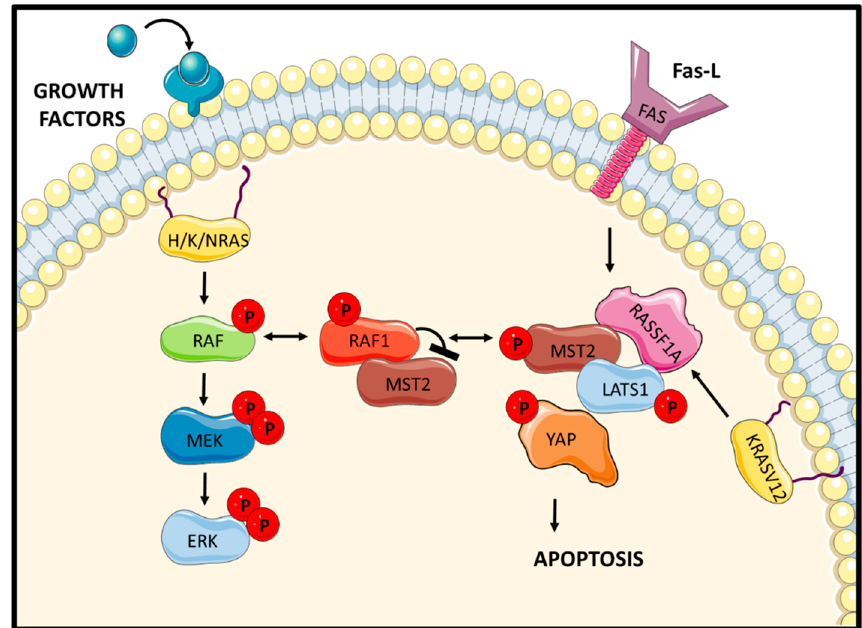
Figure 4. RAF1 negatively regulates the proapoptotic Hippo pathway by binding to MST2 upon growth factor stimulation. RASSF1A rescues MST2 from the inhibitory binding of RAF1 and regulates the activation of the core proteins of the Hippo pathway upon death receptor activation. Oncogenic KRAS also promotes the activation of the proapoptotic Hippo pathway while wildtype RAS isoforms promote RAF1–MST2 interaction.